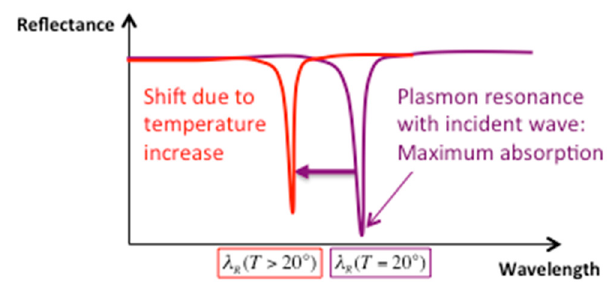
Figure 4. Scheme of reflected spectrum and wavelength resonance shift versus interface temperature.